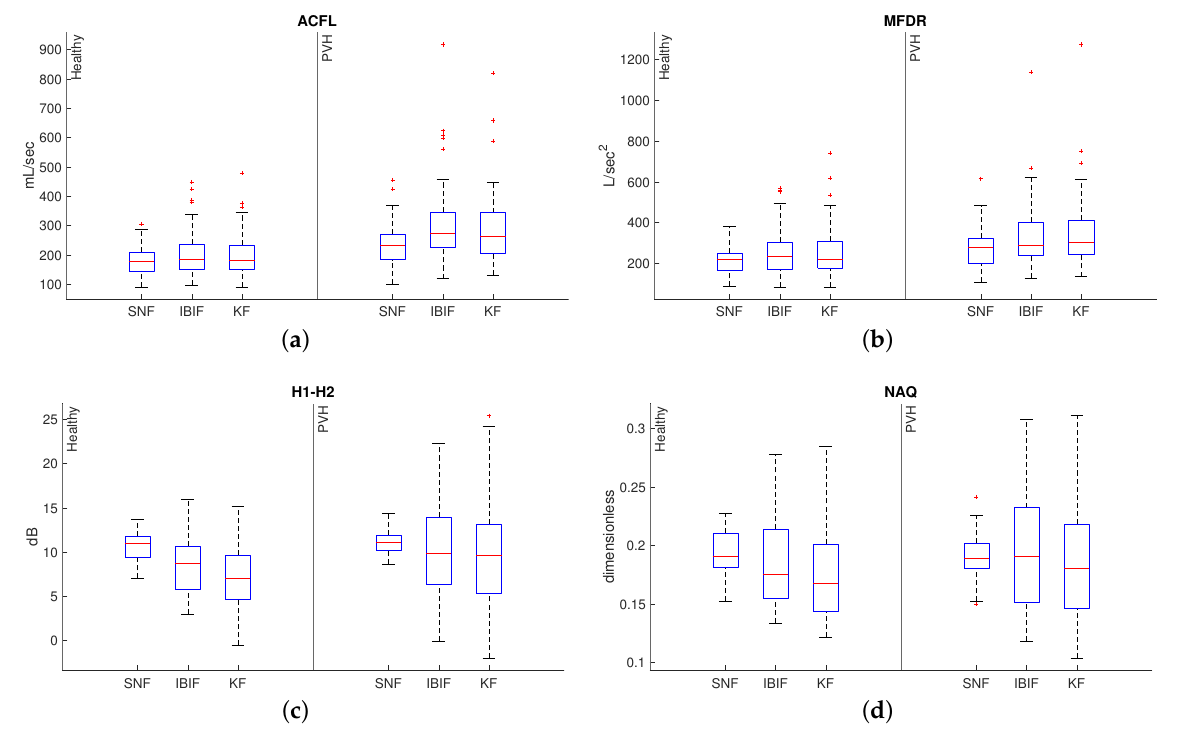
Figure 10. Distribution of average measures from the Rainbow passage for 50 vocally-healthy subjects (left panel in each subplot) and 50 PVH subjects (right panel in each subplot): ( a ) ACFL, ( b ) MFDR, ( c ) H1-H2, and ( d ) NAQ The root-mean-square-error (RMSE) between the KF implementation and the ground- truth GVV ( RMSE KF ) and the RMSE between the standard IBIF and the ground-truth GVV ( RMSE IBIF ) were calculated for each subject with voiced frames from the Rainbow Passage.The percentage of the error difference ∆ = ( RMSE KF − RMSE IBIF )/ RMSE IBIF are shown in Table 4 as the median and interquartile range for each PVH and healthy group for all the glottal features. The results indicate an improvement on the median of ACFL for both healthy and pathological using the KF implementation compared to the standard IBIF.